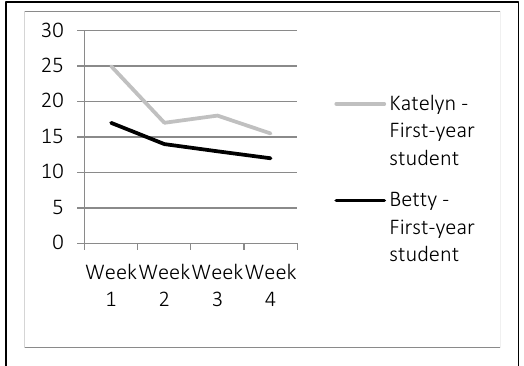
Figure 1 : First-year students’ stress levels (1- 4 weeks) using PSS results